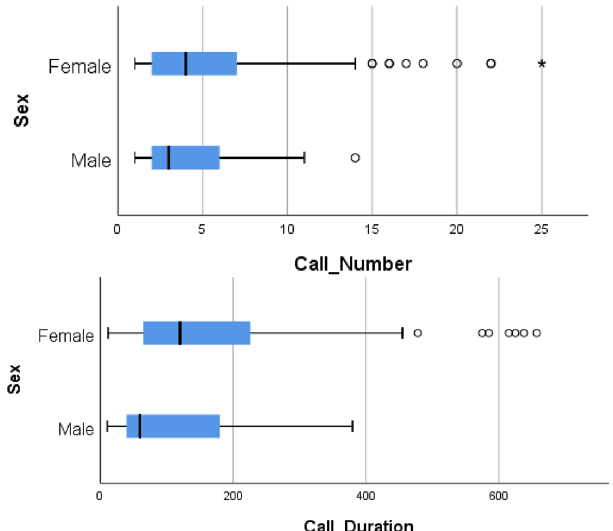
Figure 2. Boxplot of number of calls and duration of the calls, both by